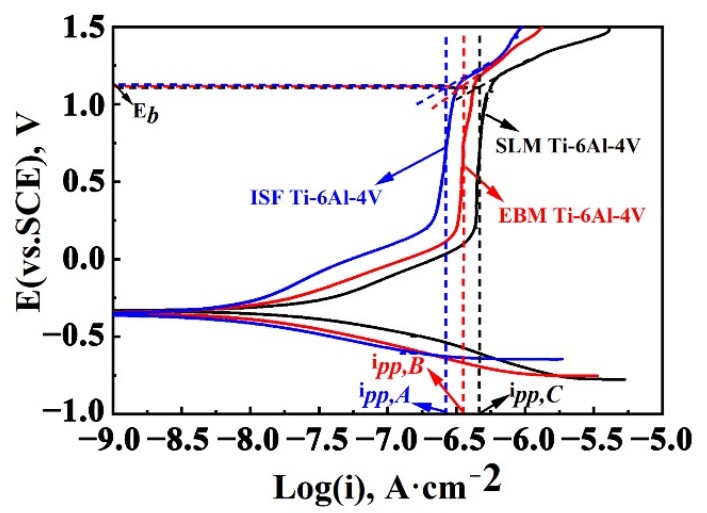
Figure 7. Potentiodynamic curves for the SLM- and EBM-manufactured Ti-6Al-4V samples and ISF alloy sample in a 3.5 wt.% NaCl solution.